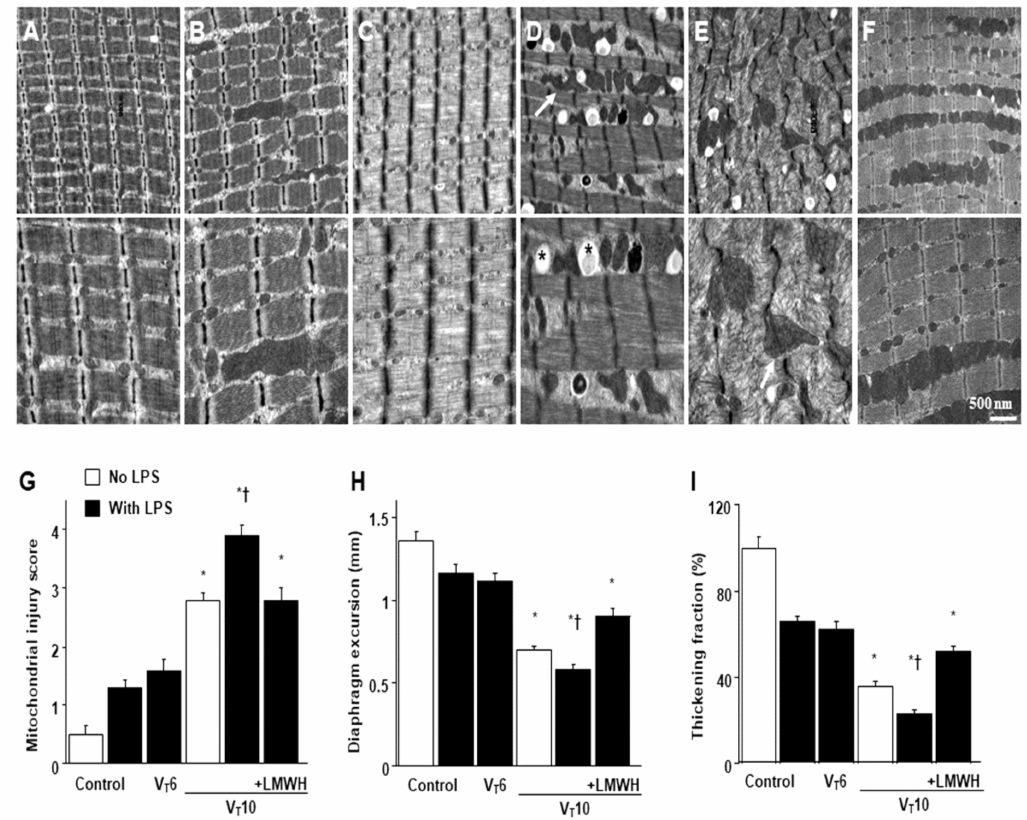
Figure 1. Electron microscopy, excursion, and thickening of the diaphragm. Representative micrographs of the longitudinal sections of diaphragm ( × 20,000: upper panel; × 40,000: lower panel) were from the same diaphragms of non-ventilated control mice and mice ventilated at a tidal volume (V T ) of 6 mL/kg (V T 6) or 10 mL/kg (V T 10) for 8 h with or without LPS administration (n = 3 per group). ( A , B ) Non-ventilated control wild-type mice with or without LPS treatment: normal sarcomeres with distinct A bands, I bands, and Z bands; ( C ) 6 mL/kg wild-type mice with LPS treatment: reduction of diaphragmatic disruption compared to that of 10 mL/kg groups; ( D ) 10 mL/kg wild-type mice without LPS treatment (normal saline): increase of diaphragmatic disarray; ( E ) 10 mL/kg wild-type mice with LPS treatment: disruption of sarcomeric structure with loss of streaming of Z bands, mitochondrial swelling, and accumulation of lipid droplets (asterisks); ( F ) 10 mL/kg wild-type mice pretreated with enoxaparin: attenuation of diaphragmatic disruption. ( G ) Injury scores of mitochondria were from the diaphragms of non-ventilated control mice and mice ventilated at a tidal volume of 6 mL/kg or 10 mL/kg for 8 h with or without LPS administration (n = 3 per group). ( H , I ) Excursion and thickness variation of diaphragm. Mitochondrial swelling with concurrent loss of cristae and autophagosomes containing heterogeneous cargo are identified by arrows. Enoxaparin, 4 mg/kg, was given subcutaneously 30 min before mechanical ventilation. * p < 0.05 versus the non-ventilated control mice with LPS treatment; † p < 0.05 versus all other groups. Scale bar represents 500 nm. LPS = lipopolysaccharide; LMWH = low-molecular-weight